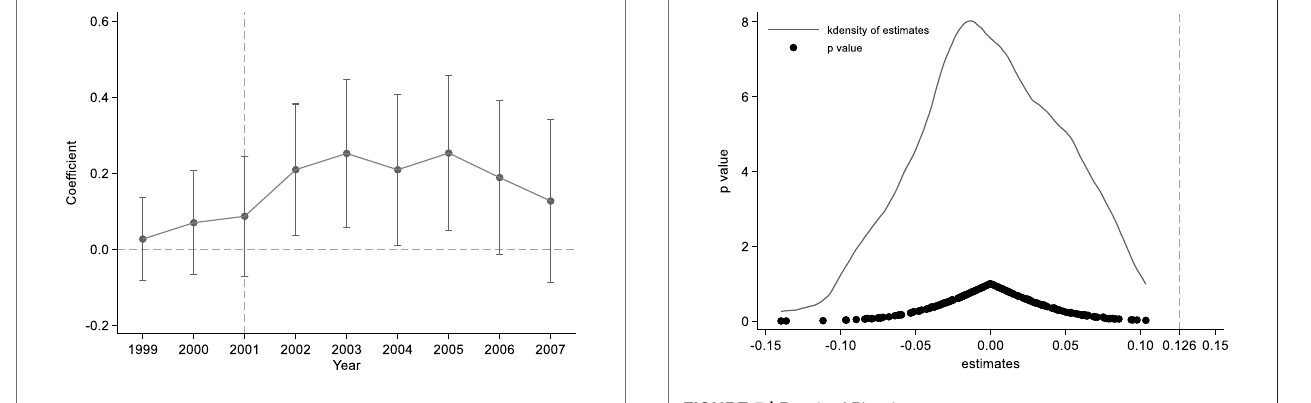
FIGURE 4 | Result of the parallel trend test. FIGURE 5 | Result of Placebo